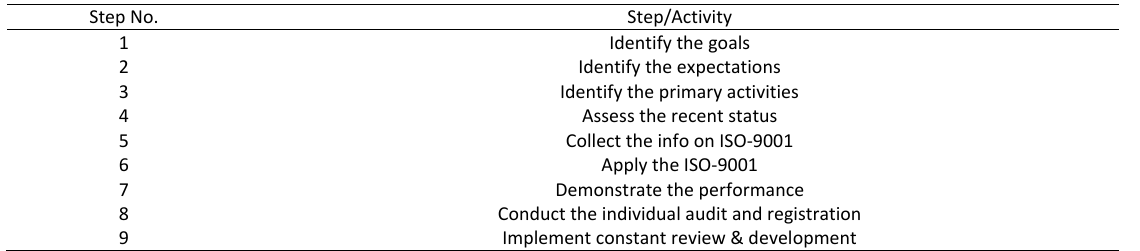
Table 3: The nine ISO 9001 implementation steps (United Nations, 2001) Step No.